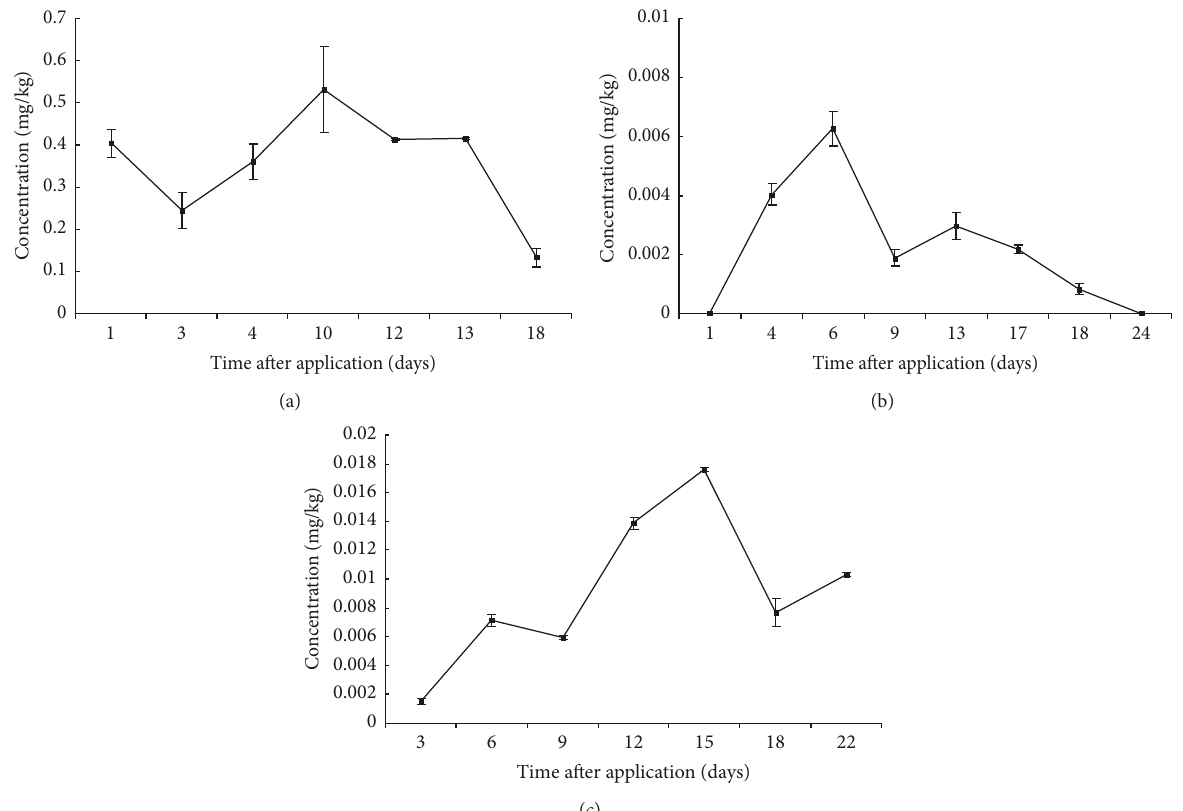
Figure 3: The concentration changes of metabolite triadimenol in apicultural products: (a) pollen, (b) honey, and (c) jelly.